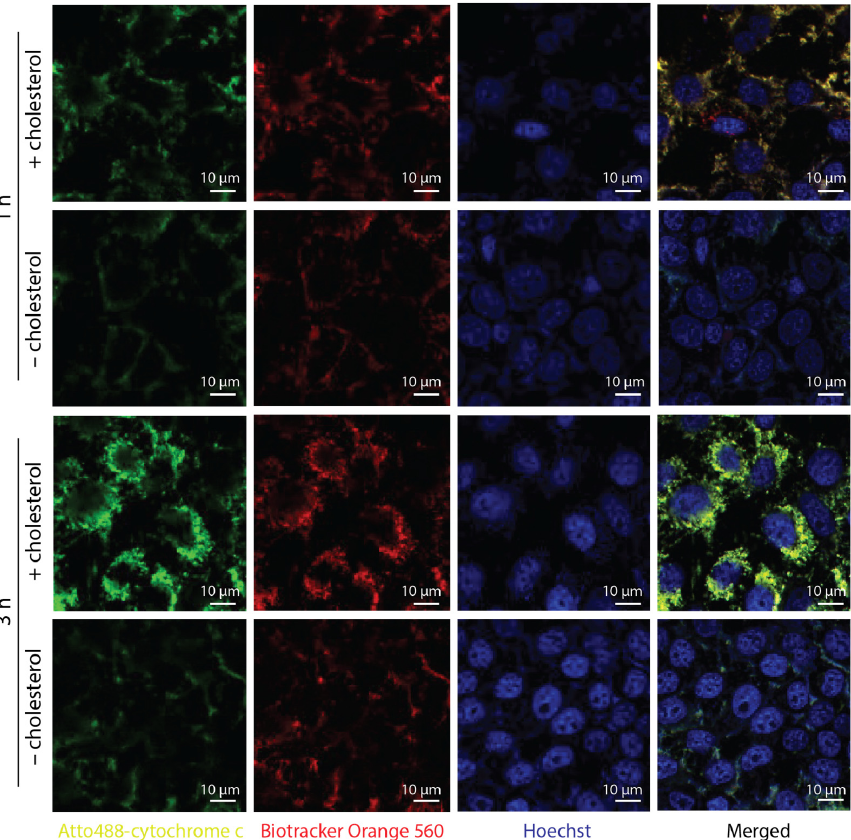
Figure 4. Confocal microscopy analysis of the cellular uptake and internalization of cytochrome c-conjugated DNA nanotubes. Cells treated with cytochrome c-conjugated DNA nanotubes (either having or lacking cholesterol) were imaged after 1 and 3 h of incubation. Cytochrome c was labelled with Atto488 before assembly of DNA nanotubes. Colocalization of nanotubes inside endosomes stained with Biotracker orange 560 lysosome dye. Scale bar: 10 µm.